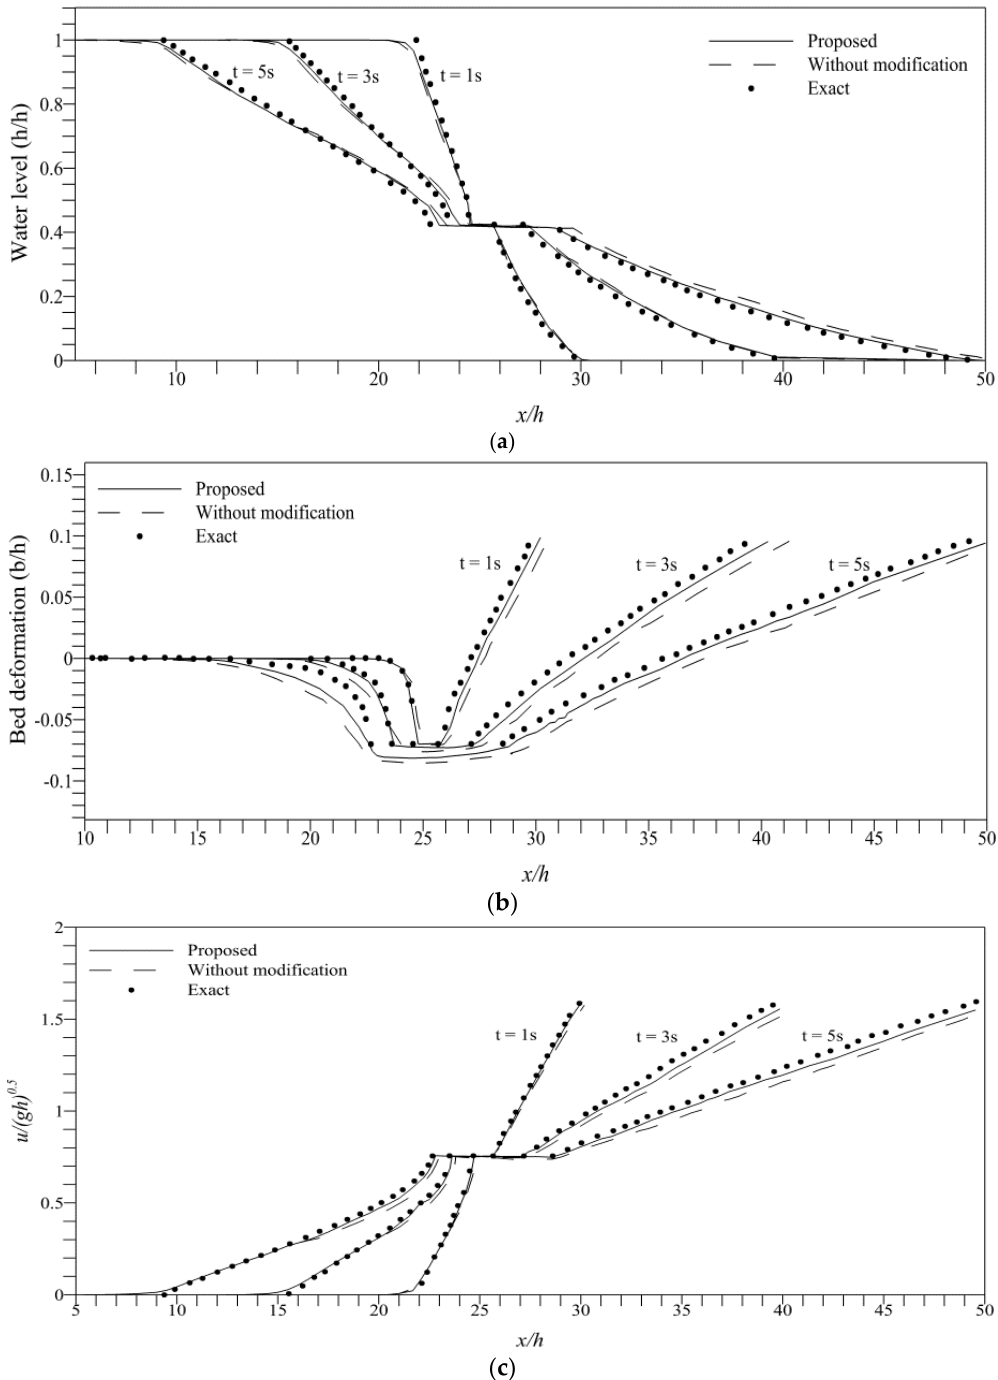
Figure 3. Comparison of ( a ) water level; ( b ) bed deformation; and ( c ) velocity with exact solution for dam-break over an erodible bed.